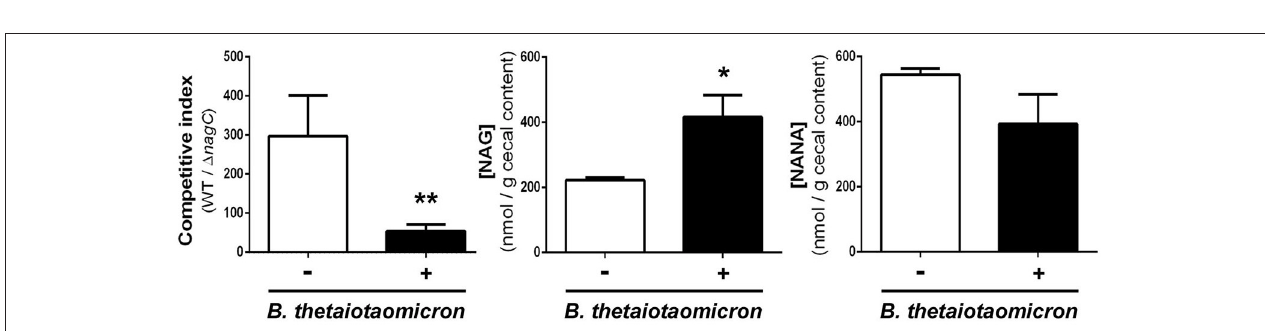
FIGURE 5 | Bacteroides thetaiotaomicron influences the outcome of wild type and 1 nagC strains in co-infected mice. Streptomycin-treated BALBc were infected with a 1:1 mixture of wild type and 1 nagC EDL933 strains. Mice were gavaged or not daily with 5 × 10 9 B. thetaiotaomicron cells starting 1 day before EHEC infection. Competitive indices WT/ 1 nagC and concentrations of NAG and NANA obtained at day 8 post-infection in the cecal contents of mice treated or not with B. thetaiotaomicron are shown. * p < 0.05 and ** p <